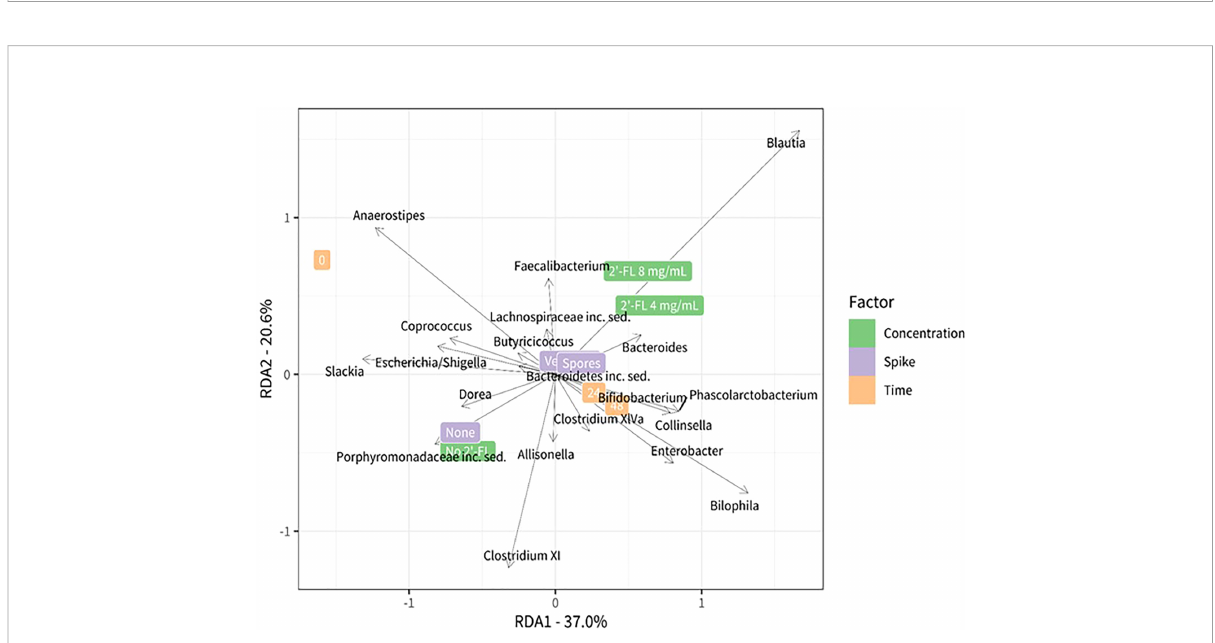
FIGURE 5 Redundancy analysis plot using center-log transformed data showing the relationship between the test conditions and bacterial genera. Different test conditions are highlighted on the right side of the plot green: concentration 2 ’ -FL, violet: C. dif fi cile spike, orange: timepoints. The position in the plot is determined by the microbiota composition in the corresponding condition. The black vectors represent the bacteria that are most associated with the test conditions: their length and orientation are indicative of their relationship with the different test conditions.